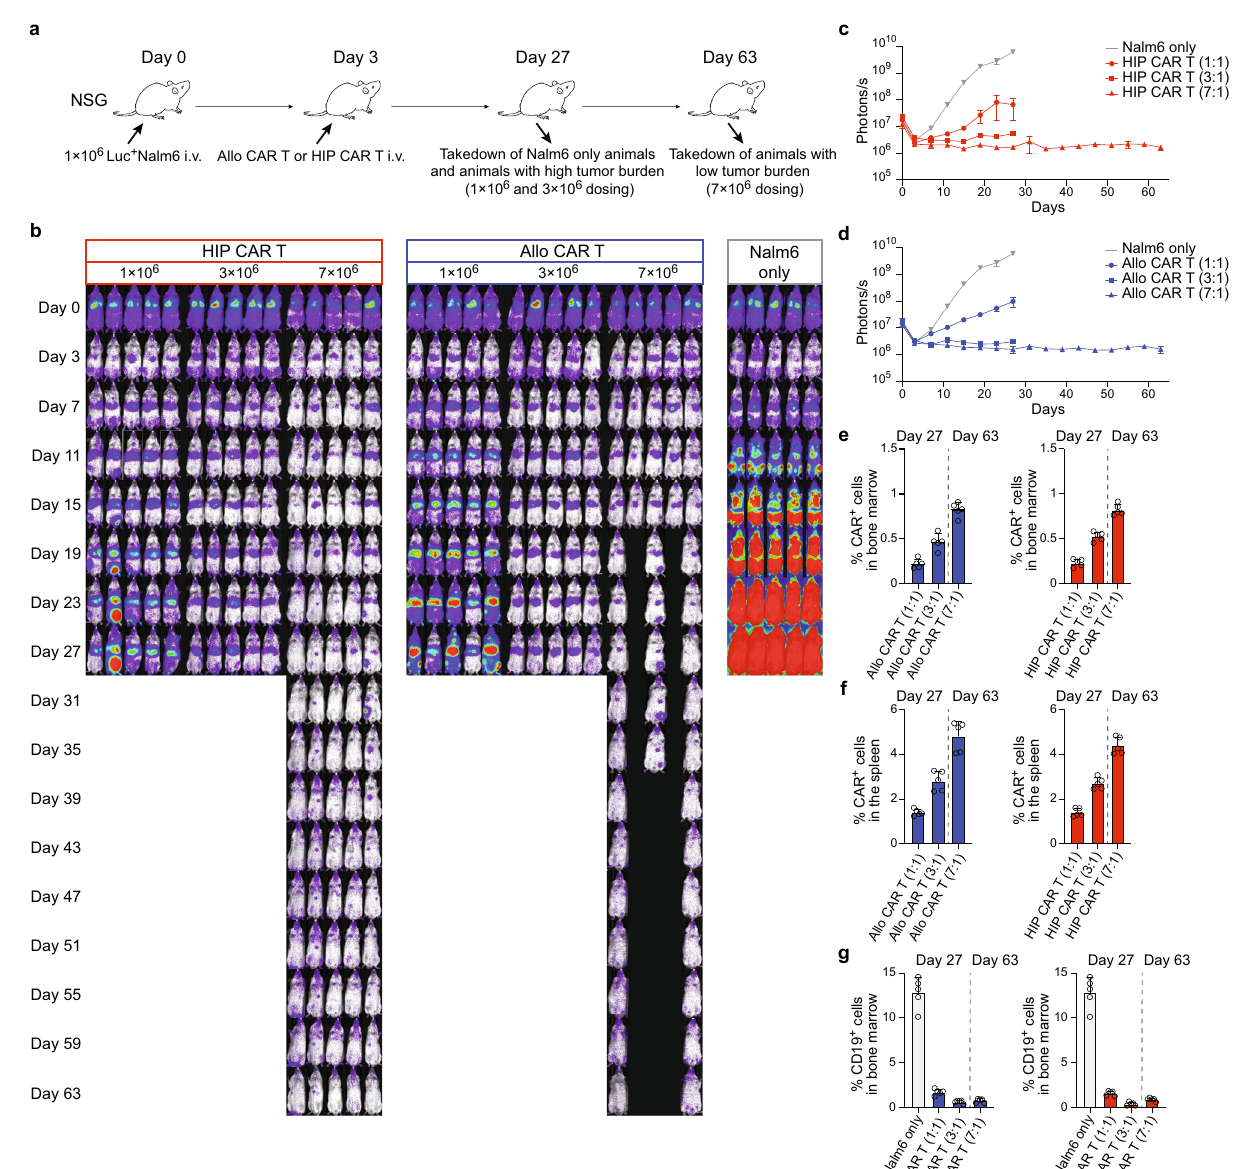
Fig. 2 | Nalm6 tumor killing in NSG mice. a Immunode fi cient NSG mice were injected with 1×10 6 Luc + Nalm6 cells via the tail vein and were followed by BLI. Some mice then received allo CAR T cells or HIP CAR T cells ( n =5 mice in each group in one experiment) intravenously on day 3. Spleen and bone marrow were taken after 27 or 63 days. b BLI images show the tumor burden for all mice in this study. c , d Graphs show BLI signals for animalsinthe HIP CAR T ( c ) and allo CART cell groups ( d , mean±SEM, n =5 animals per group). e , f The percentage of CAR + proteinseffectivelyabolishedtheanti-tumoref fi cacyofHIPCARTcells